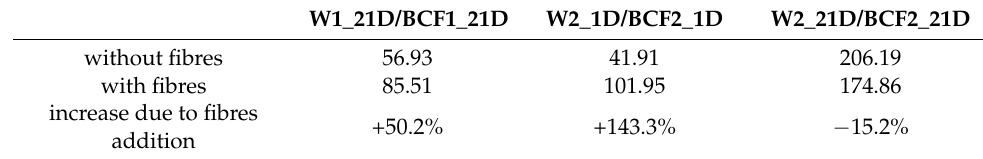
Table 5. Mean value of fracture energy, G F (N/m).